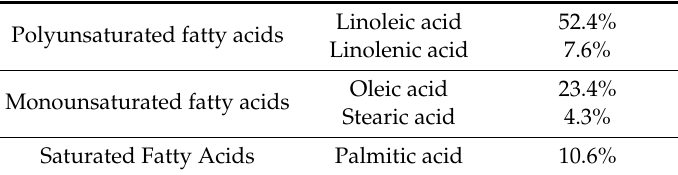
Table 2. Ingredients of natural insulation oil